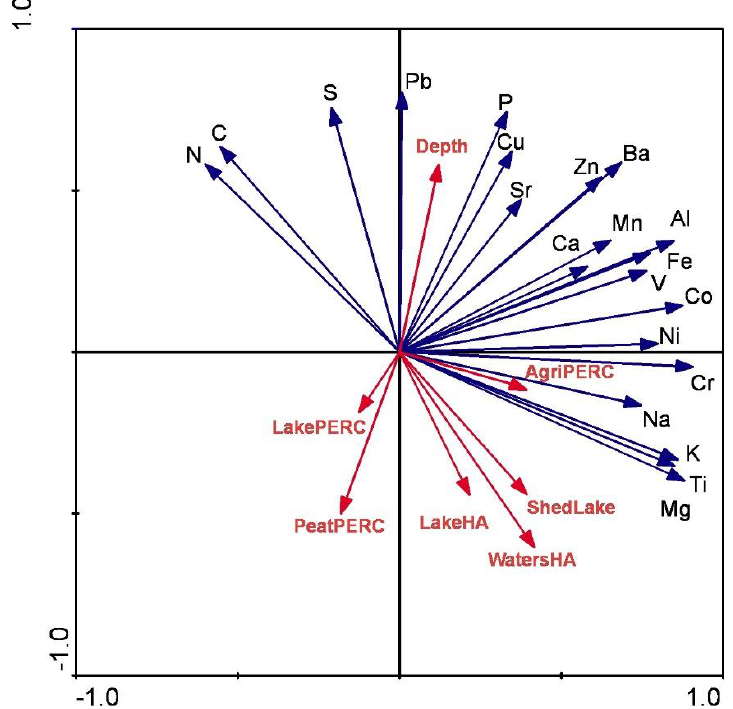
Figure 10. PCA plot of predisturbance (bottom) samples, chemical component results, and environmental variables (log10 transformation was used). In the predisturbance state, agricultural land use acts as a surrogate variable for fine-grained soils suitable for agriculture.